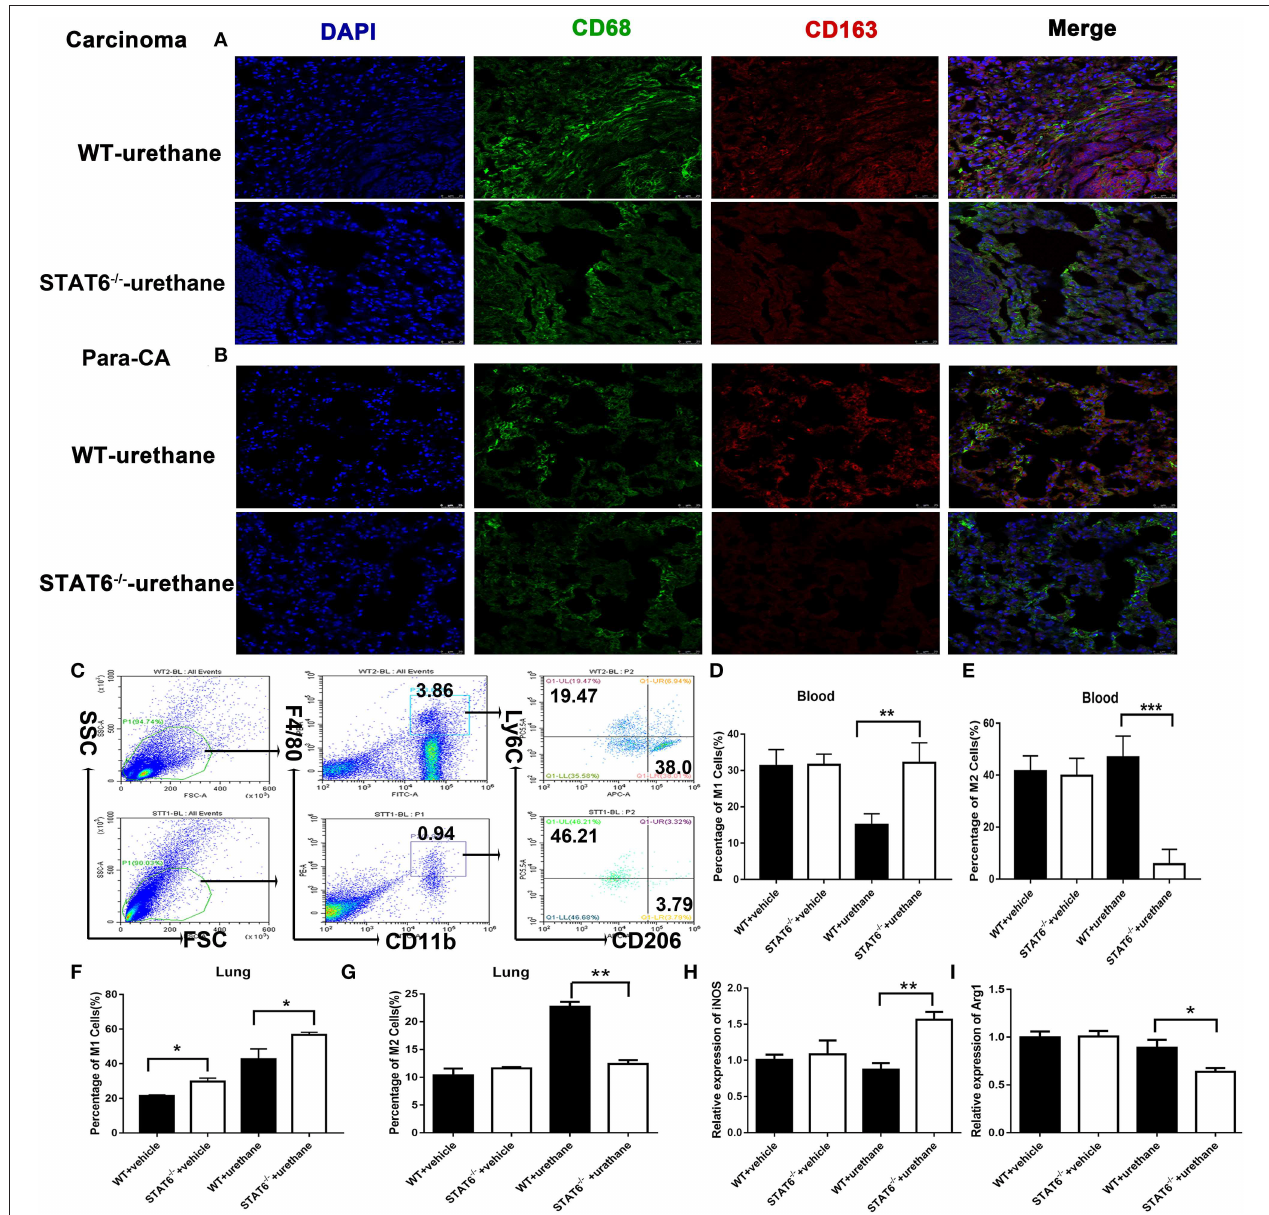
FIGURE 6 | M1 and M2 mobilization in the lung of signal transducer and activator of transcription 6 (STAT6)-deficient mice. (A,B) Fluorescent images of CD68 (green) and CD163 (red) in lung carcinoma and para-carcinoma tissues of WT and STAT6 − / − tumor-bearing mice. (C) Flow cytometry analysis of M1 and M2 cells. (D–G) . M1 and M2 cells in WT and STAT6 − / − tumor-bearing mice. (D) Percentage of M1 cells (CD11b + F4/80 low Ly6C high CD206 − ) in the blood. (E) Percentage of M2 cells in the blood (CD11b + F4/80 high Ly6C − CD206 + ). (F) Percentage of M1 cells in the lung. (G) Percentage of M2 cells in the lung. (H) Relative mRNA expression of iNOS in CD11b + cells isolated from the lung. (I) Relative mRNA expression of Arg1 in CD11b + cells directly obtained from mice. Total number of gated cells was 10 × 10E4. * P < 0.05, ** P < 0.01, *** P <